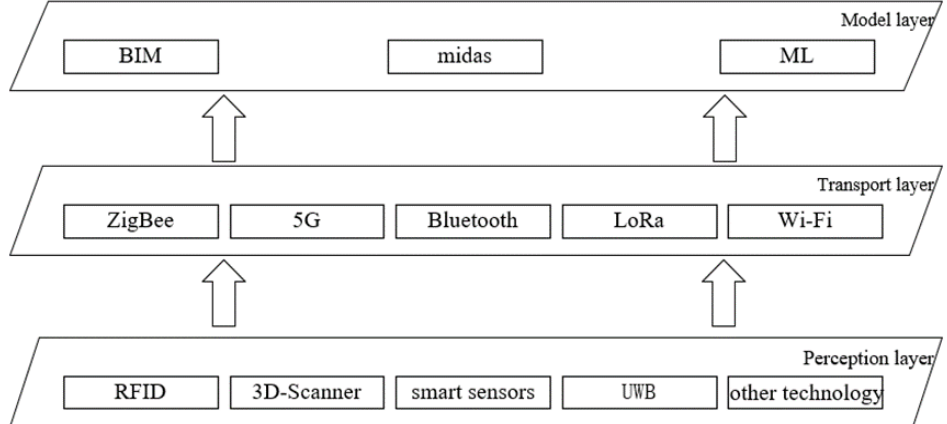
Figure 5. Information collection process based on the IoT.